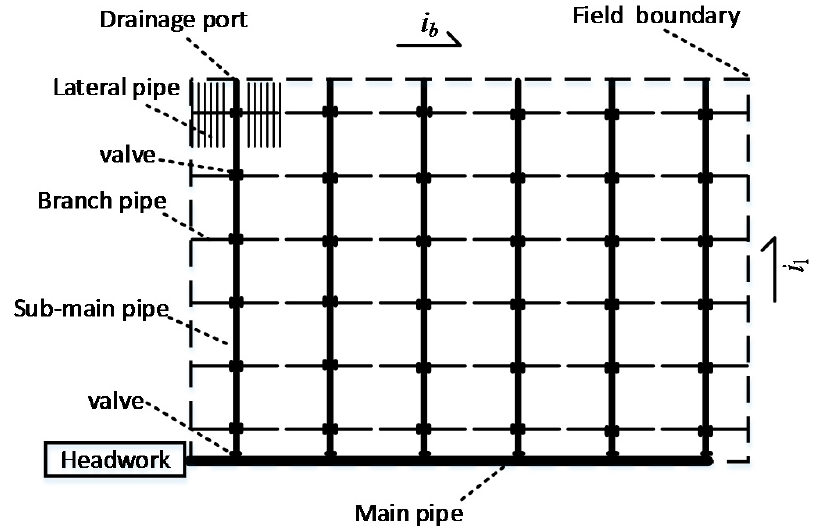
Figure 1. Schematic of a self-pressurized drip irrigation network system.